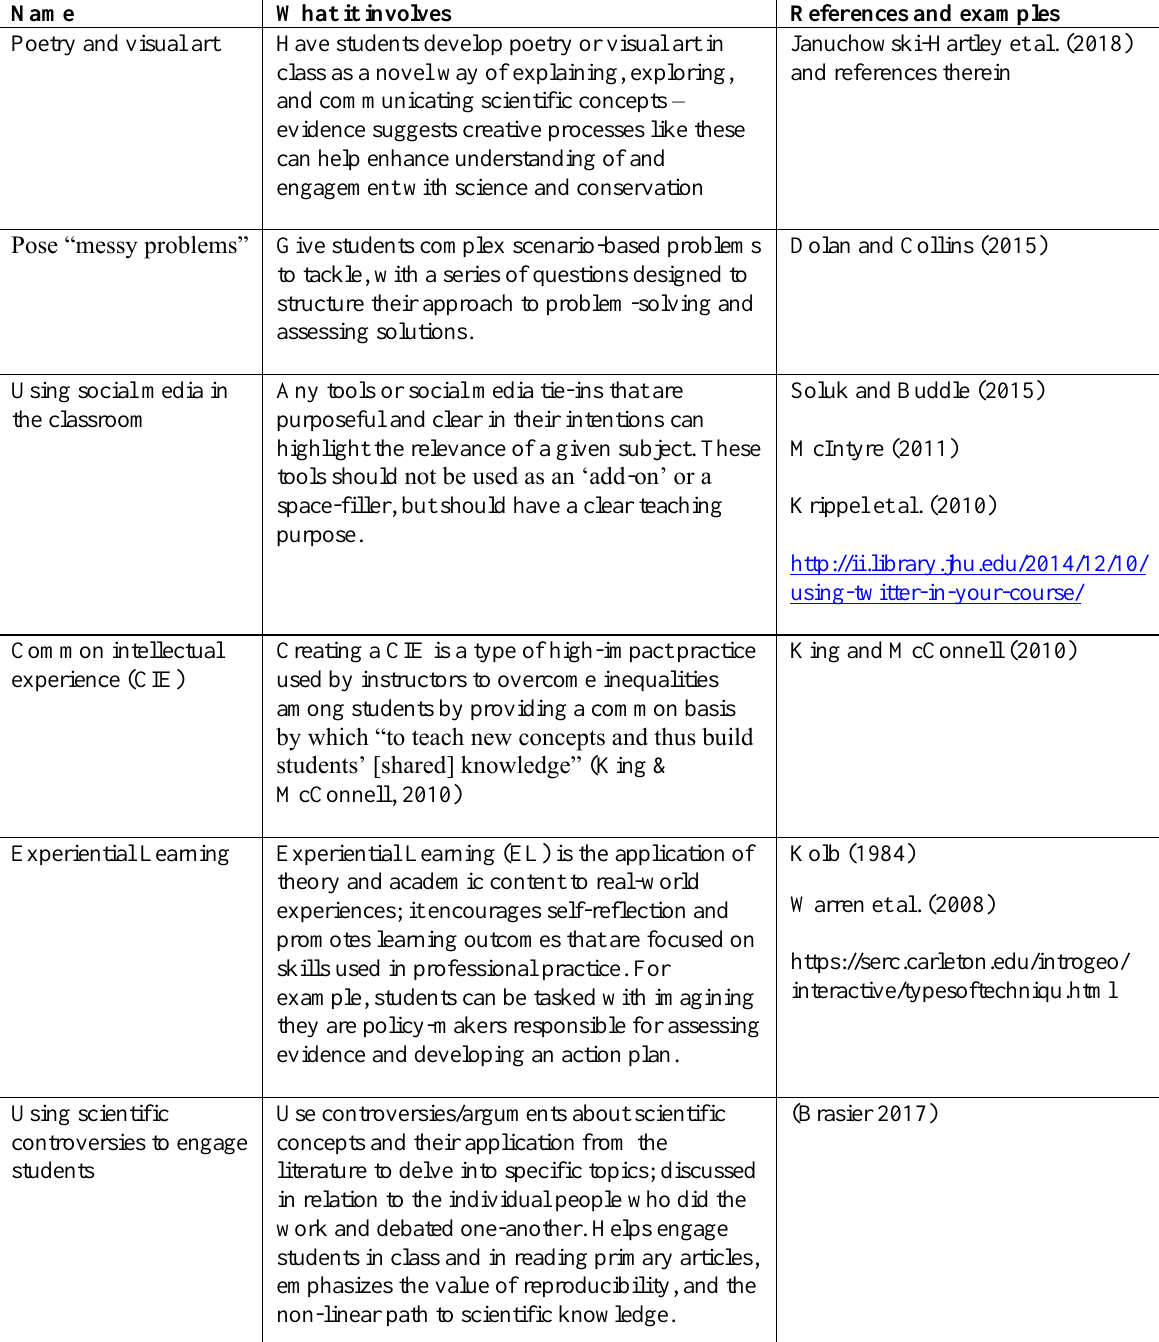
Table A2 . Examples of non-traditional, creative teaching approaches to consider trying in the classroom (dependent on class size and subject area). Also see Nordlund (2016) for a useful set of examples for ecology